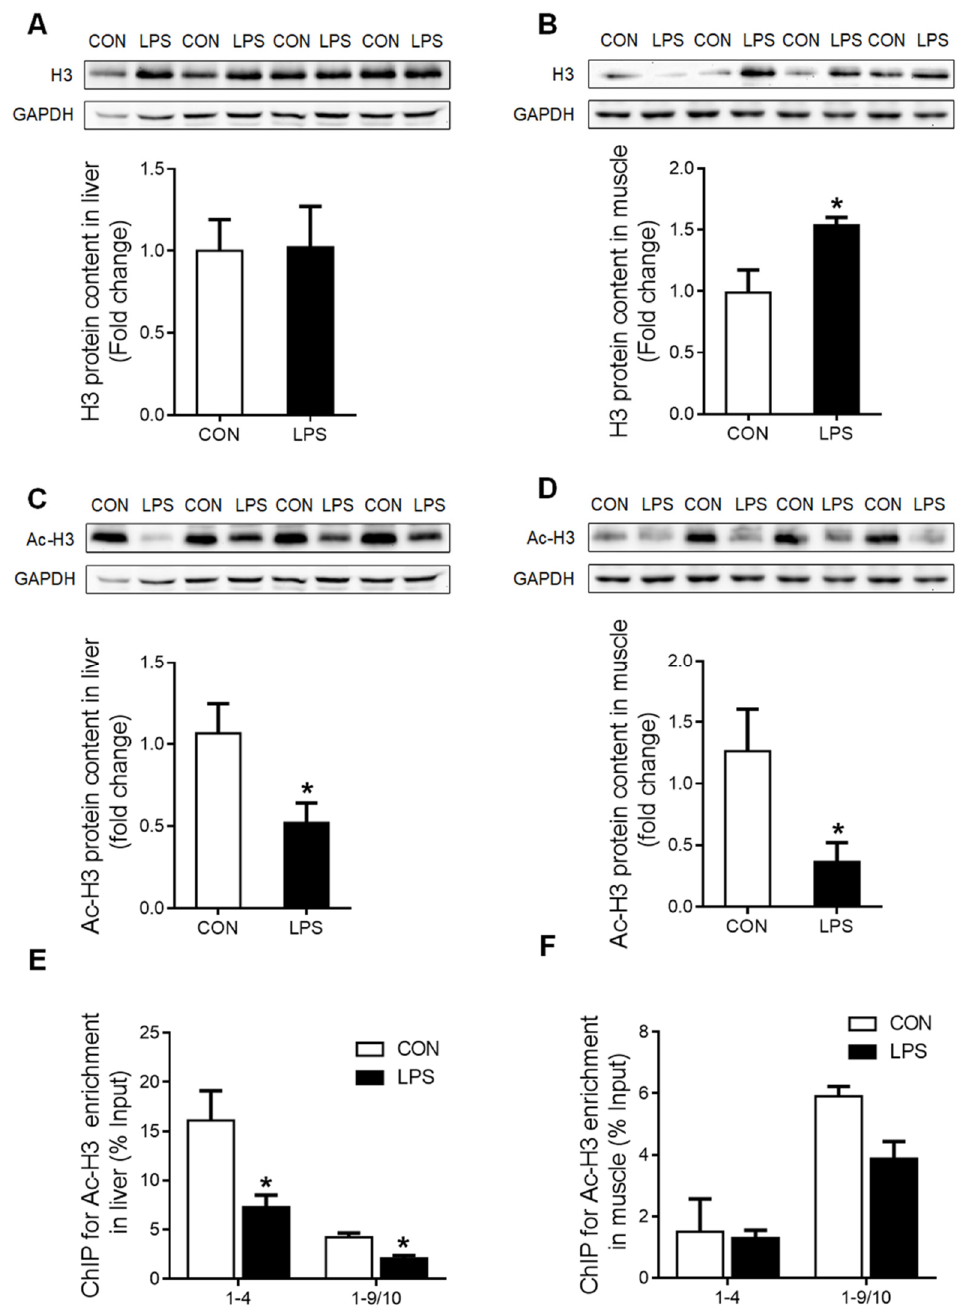
Figure 5. Histone H3 protein content and the enrichment of histone H3 acetylation on GR promoters 1–4 and 1–9/10 under LPS stimulation. ( A ) Western blot and densitometric analyses of H3 and GAPDH proteins in the liver. ( B ) Western blot and densitometric analyses of H3 and GAPDH proteins in muscle. ( C ) Western blot and densitometric analyses of the global histone H3 acetylation level in the liver. ( D ) Western blot and densitometric analyses of the global histone H3 acetylation level in muscle. ( E ) ChIP analyses for Ac-H3 enrichment on the promoter of GR exon 1–4 and 1–9/10 in the liver. ( F ) ChIP analyses Ac-H3 enrichment on the promoter of GR exon 1–4 and 1–9/10 in muscle. Values were expressed as means SEM, n = 4 in each group, * p < ±